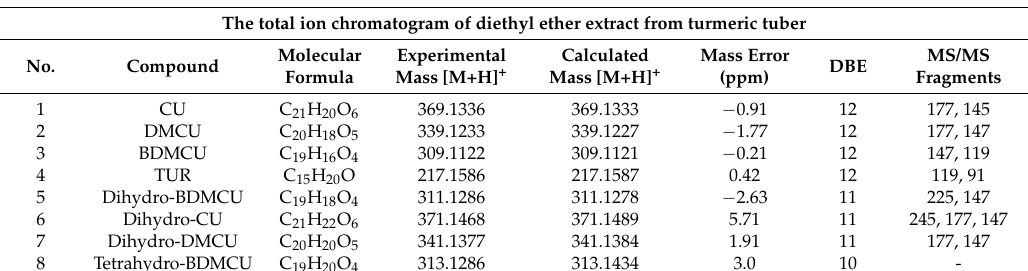
Table 1. LC-ESI-Q-TOF-MS accurate mass measurements of phenolics and terpenes identified in the MeOH and diethyl ether extracts of Curcuma longa